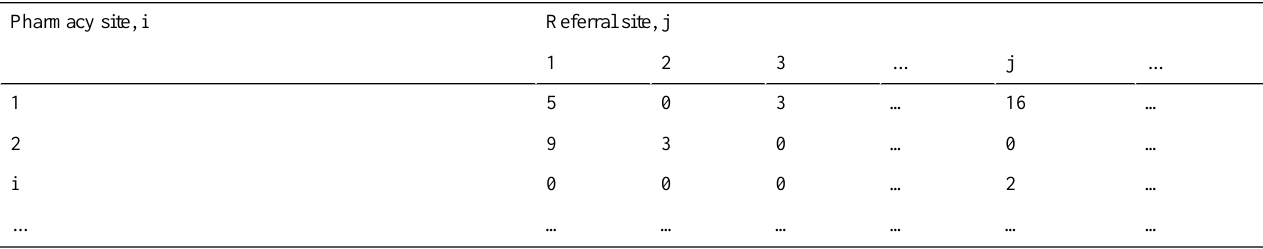
Table 2. Demonstration of our data set for the prediction model.